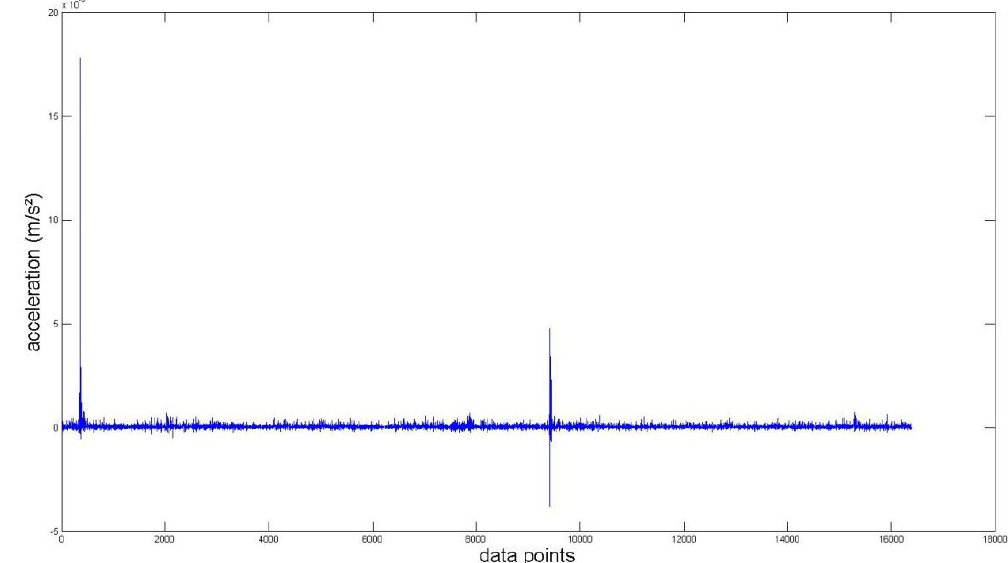
Figure 9. Vibration data points after applying MED first, and then TKEO signal processing on a damaged bearing (Case IV).